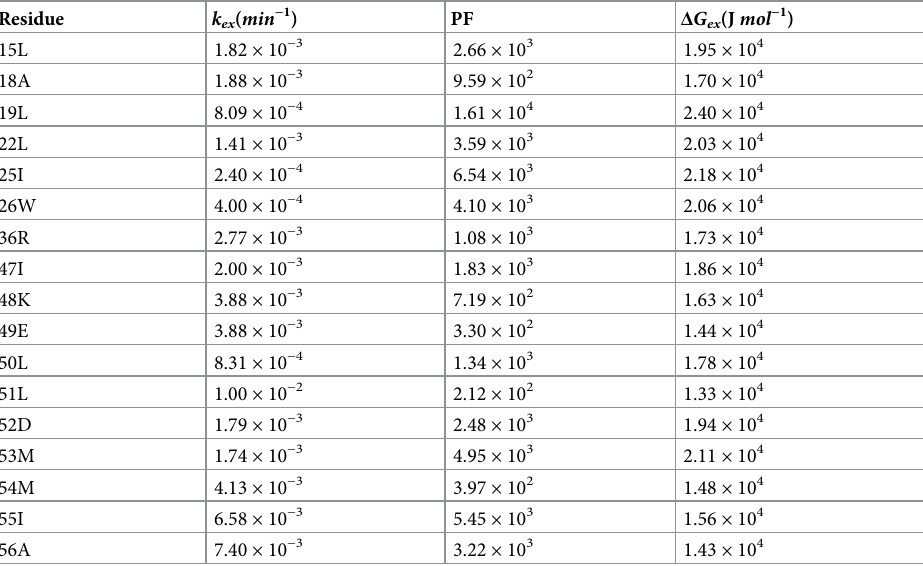
Table 1. Hydrogen-deuterium exchange data of PRC1-DD backbone amides.